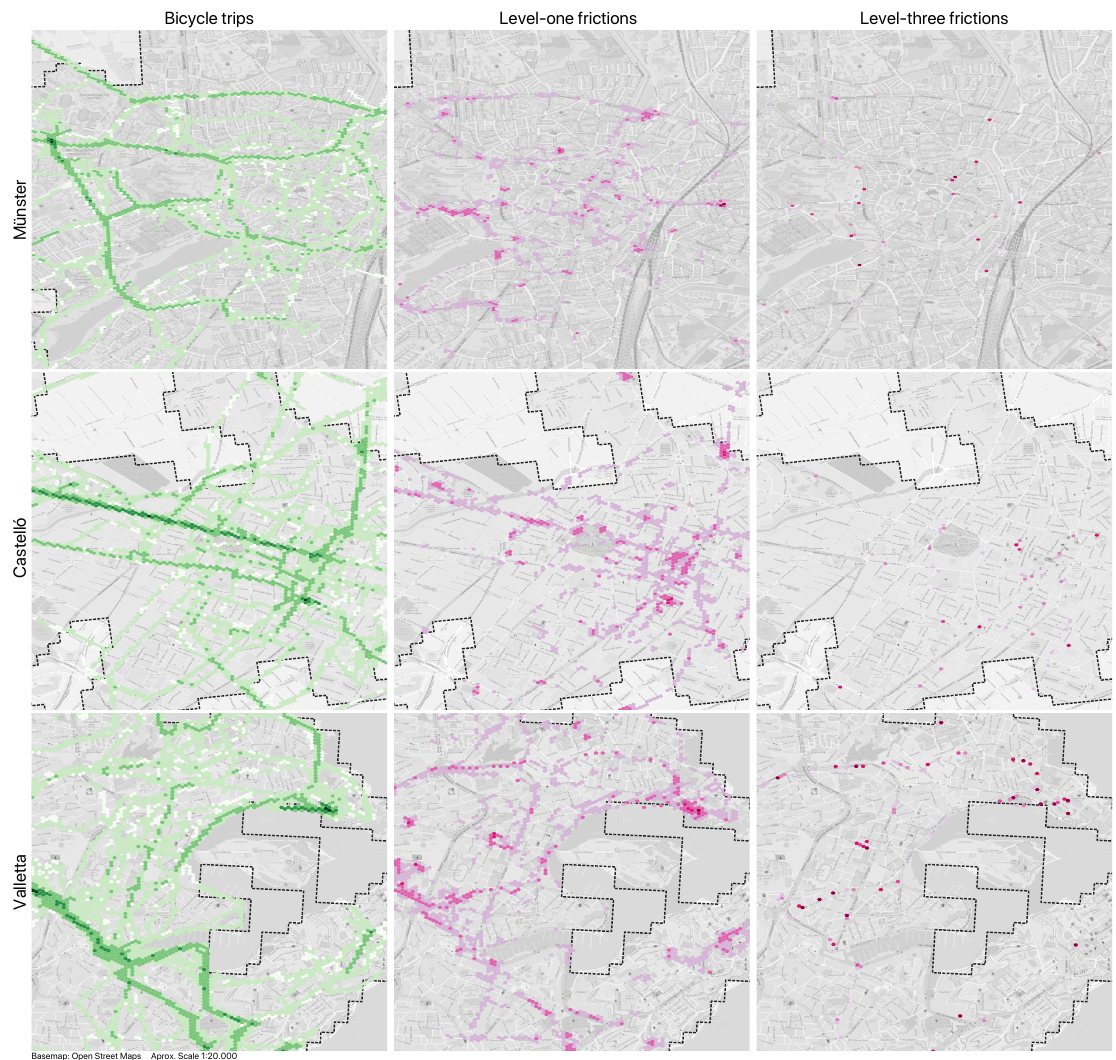
Figure 7. Bicycle trips, first and third level